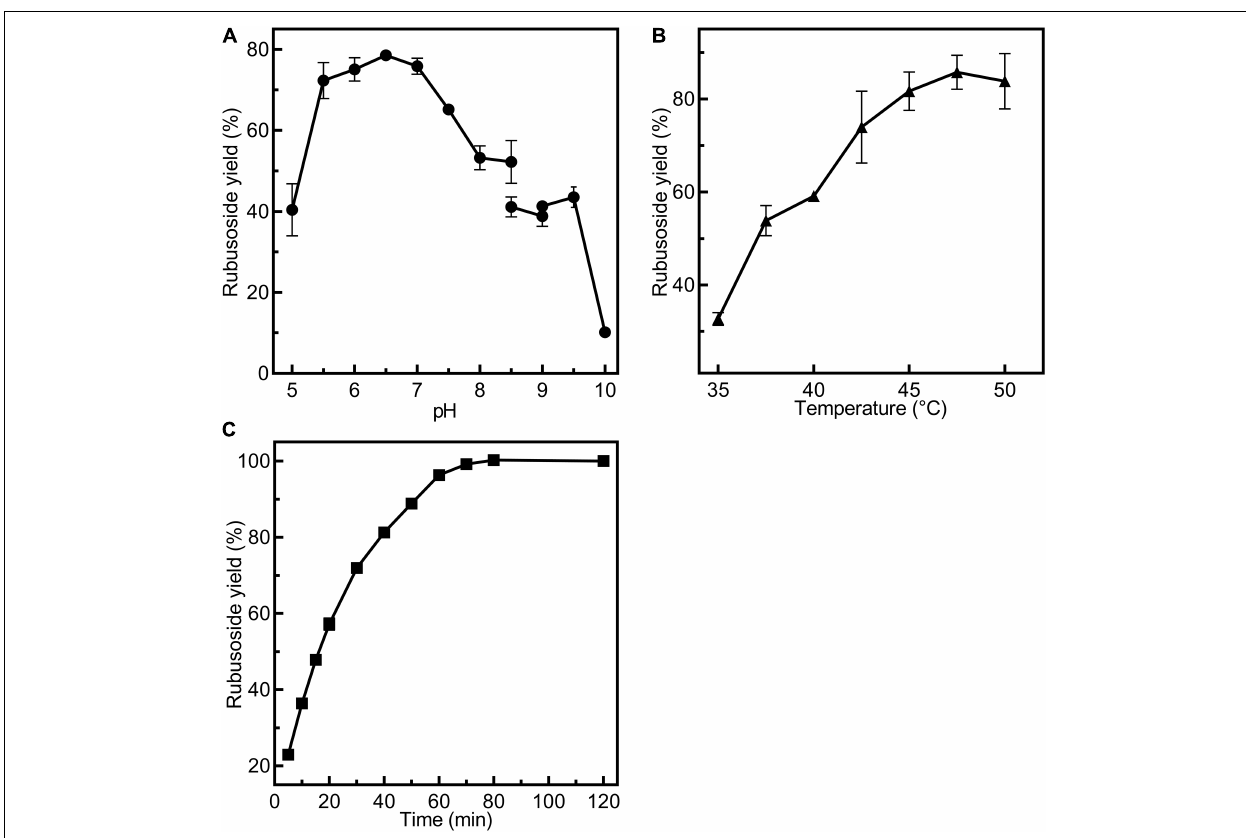
FIGURE 5 | Condition exploration for production of rubusoside using 30.9 U/ml Cs BGL and 240 g/L stevioside. (A) Effects of pH on the rubusoside yield. Reactions were performed at 45 ◦ C for 40 min at various pH values from 5 to 10. (B) Effects of temperature on the rubusoside yield. Reactions were performed in 50 mM sodium phosphate buffer (pH 6.5) for 40 min at several different temperatures ranging from 35 to 50 ◦ C with 2.5 ◦ C intervals. (C) The time course of rubusoside yield from 5 to 120 min. Reactions were performed in 1 ml 50 mM sodium phosphate buffer (pH 6.5) at 47.5 ◦ C for 5 to 120 min. A 50 µ l sample was taken out